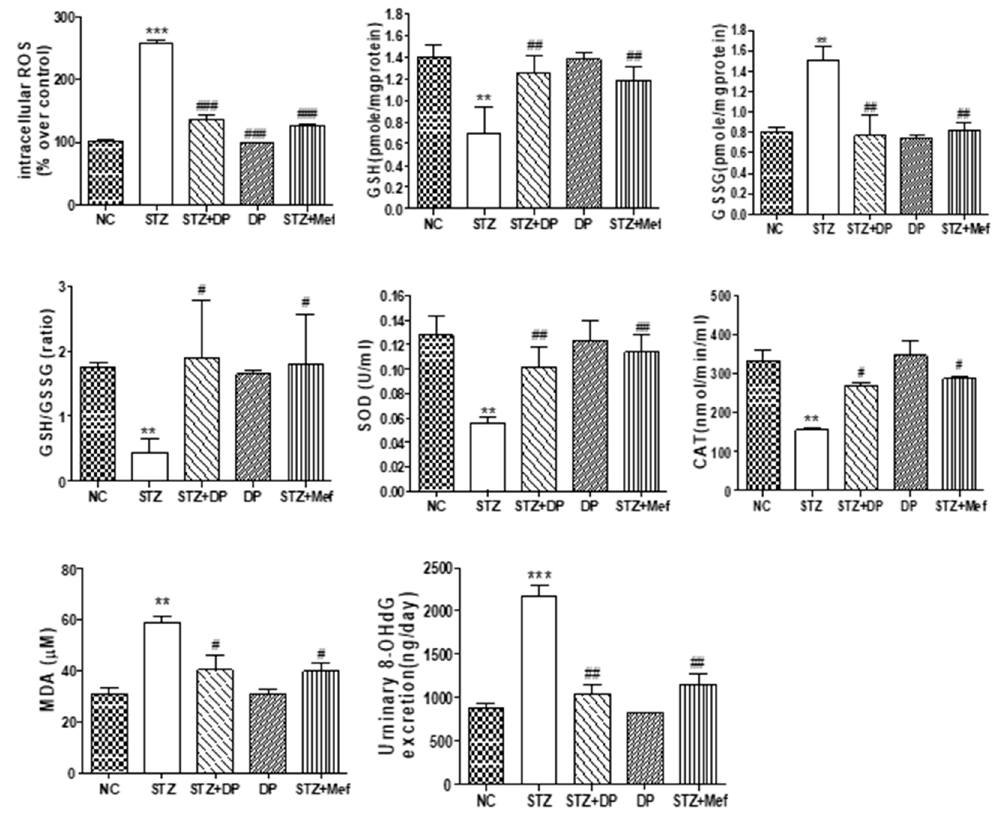
Figure 5. E ff ect of DP extract on antioxidant enzyme activity and oxidative stress in the kidney of STZ-induced diabetic rats. Changes in oxidative biomarkers (reduced glutathione (GSH), glutathione and oxidized GSH (GSSG), GSH / GSSG, superoxide dismutase (SOD), and catalase) were measured in the kidney. Intracellular reactive oxygen species (ROS) and oxidative DNA damage marker 8-Hydroxy-2’-deoxyguanosine (8-OHDG) were measured in the kidney. Data are expressed as the means ± S.D. of duplicate experiments (6 animals / group). Statistical analysis was performed by one-way ANOVA followed by Tukey’s HSD post hoc test for multiple comparisons. *** p < 0.001 and ** p < 0.01 compared to control group; # p < 0.05 and ## p < 0.01, ### p < 0.001 compared to STZ-treated